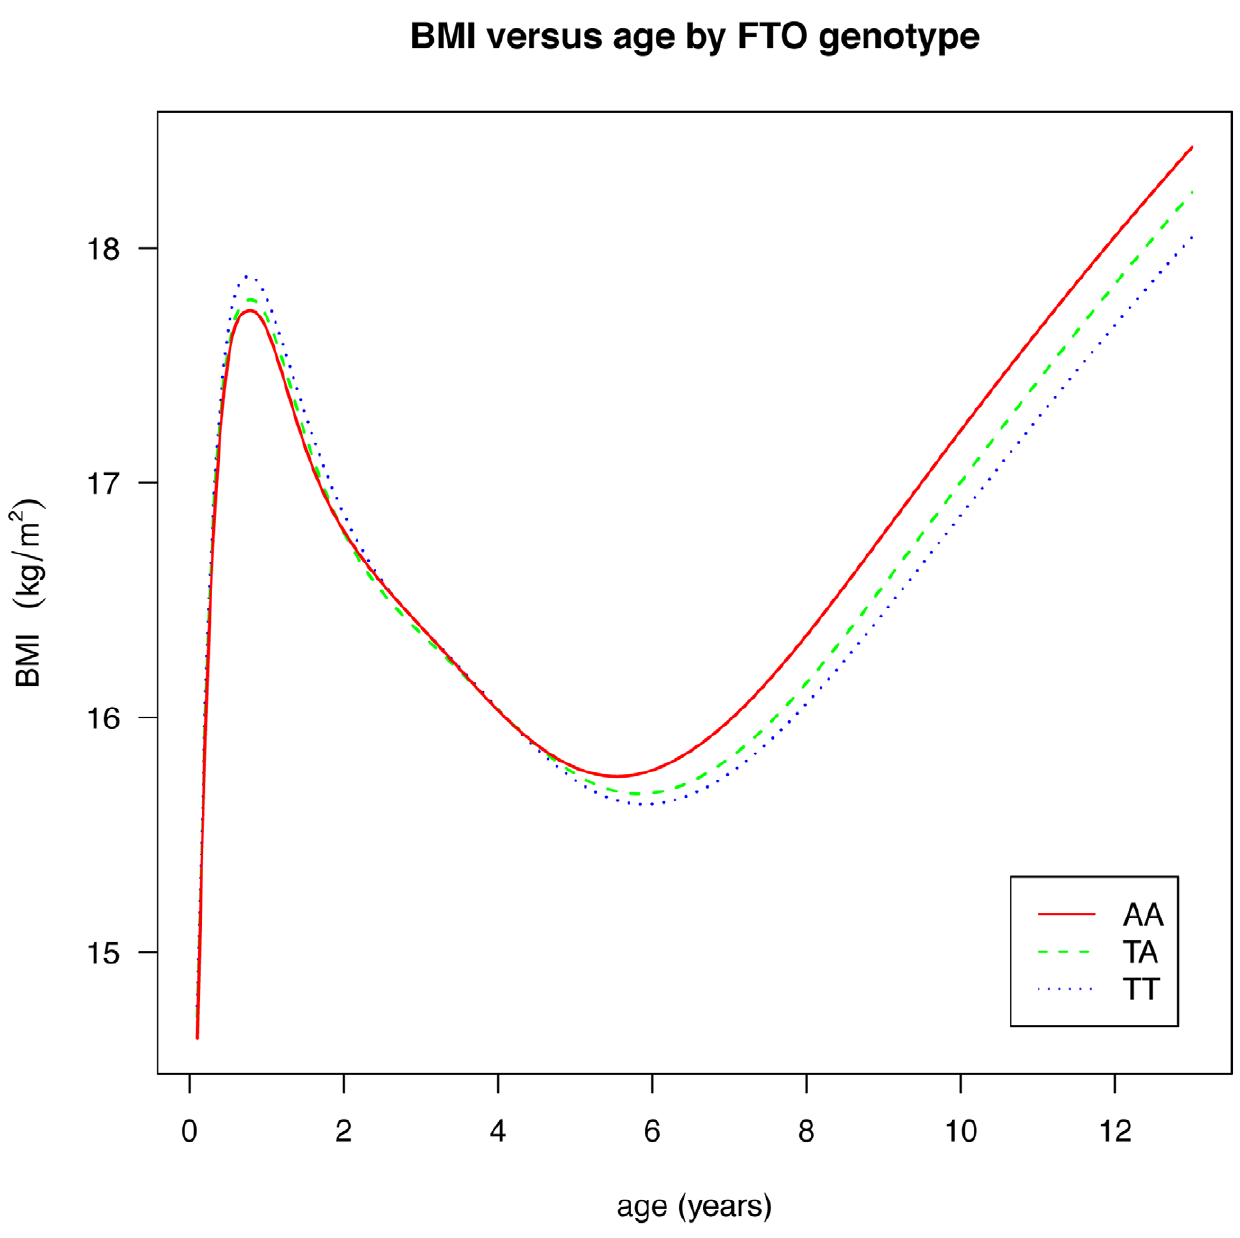
Figure 2. Curves of median BMI by age and genotype at rs9939609, estimated by the LMS method and adjusted for study and sex.